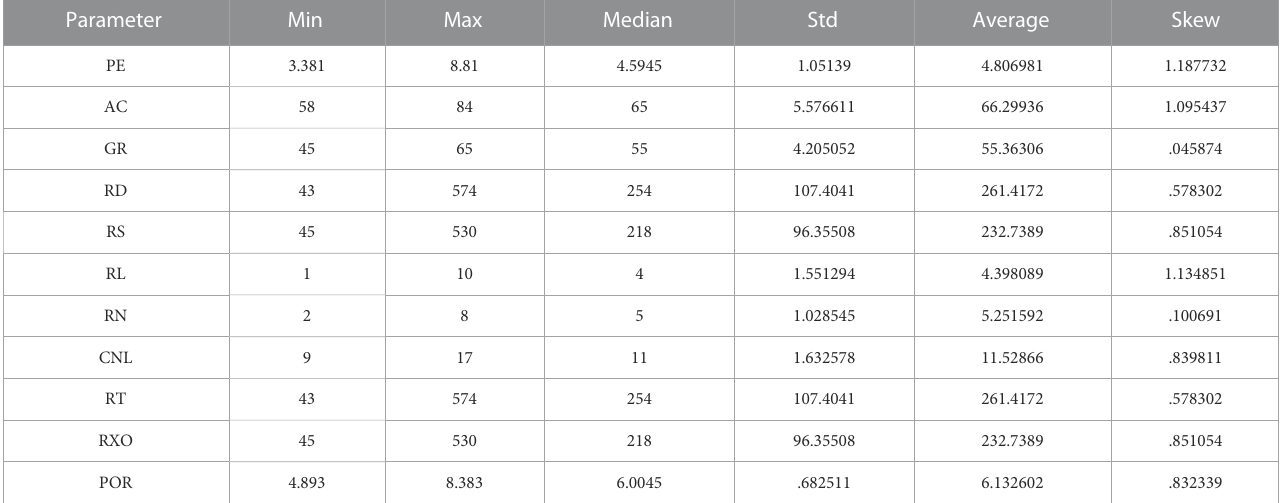
TABLE 1 Statistical values of various logging parameters.